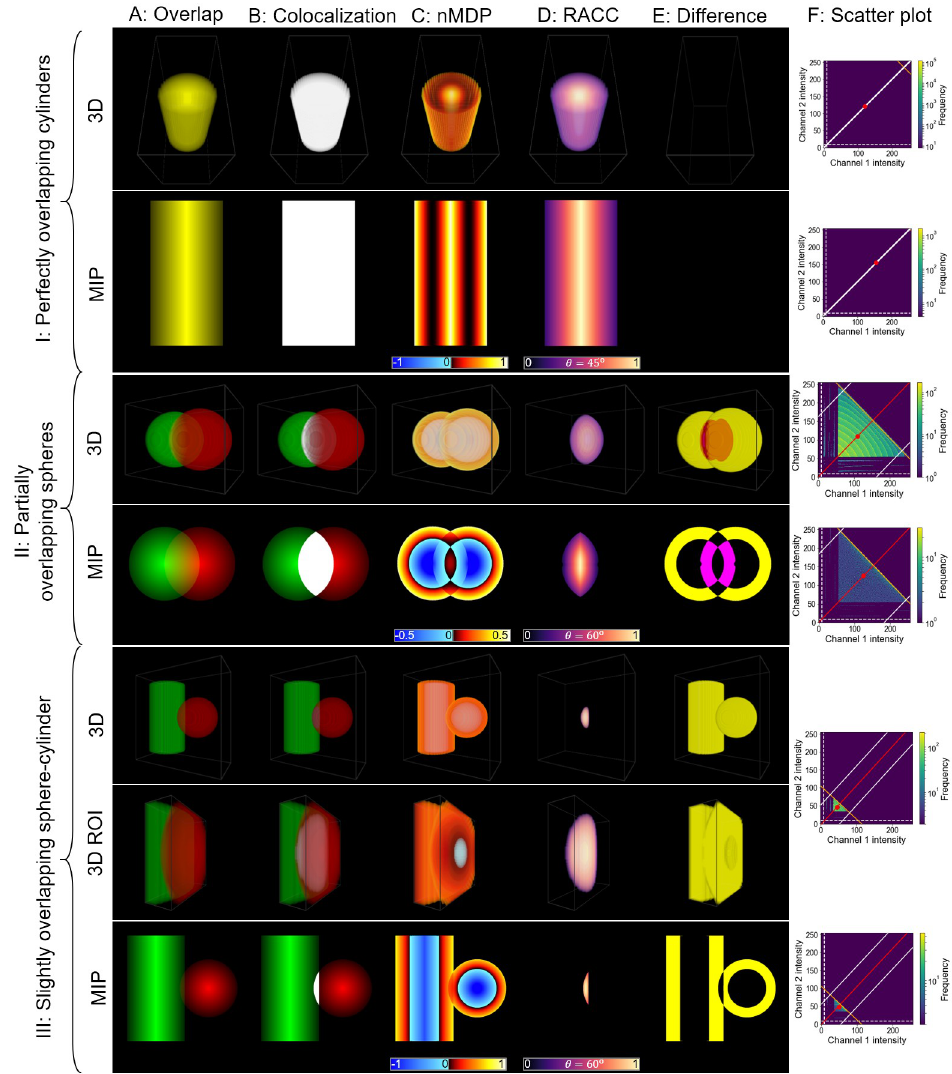
Fig 5. Visualisation of synthetic data using both 3D images and maximum intensity projections (MIP). A: The overlapping fluorescence channel intensities. B: All voxels above the colocalisation thresholds and therefore considered colocalised are overlaid in white. C: The result of applying the nMDP. D: The result of applying RACC. E: The difference between RACC and the nMDP. Magenta represents areas which nMDP considers not-colocalised but that RACC considers colocalised, while yellow represents areas that nMDP considers colocalised but RACC does not. F: Scatter plots for the 3D and MIP datasets, showing the frequency of each colocalisation intensity. The regression line calculated by RACC is shown in red. The maximum and distance thresholds for RACC are shown in orange and white, respectively. The red marker represents the per-channel average intensities used by the nMDP calculations and around which the four quadrants are separated (see Fig